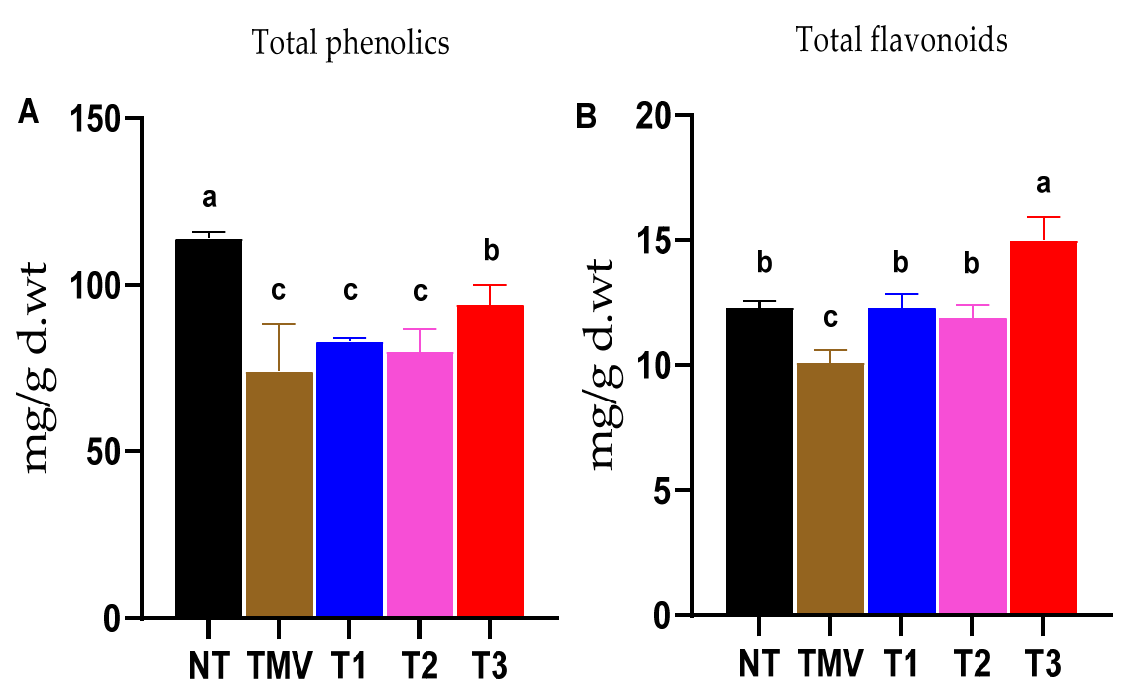
Figure 5. Effect of foliar application of B. subtilis strain HA1-culture filtrate on the total phenolic ( A ) and total flavonoid ( B ) contents of tomato plants at 22 days post-TMV inoculation. NT: mock plants; TMV: virus-infected plants; T1: tomato plants sprayed with bacterial culture filtrate 24 h before virus infection; T2: tomato plants sprayed with bacterial culture filtrate 24 h after virus infection; T3: to- mato plants sprayed with bacterial culture filtrate two times, 24 h before and 24 h after virus inocu- lation. Each column value represents the mean result obtained from five biological replicates.